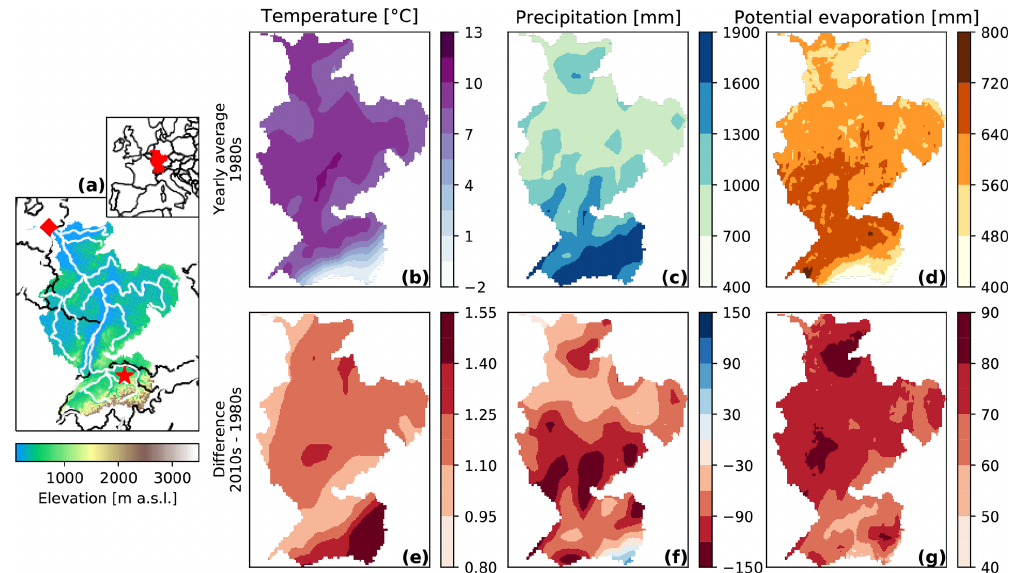
Figure 1. Digital elevation model of the Rhine, and hydro-meteorological changes between the 1980s and the 2010s. Panel (a) shows the simulation domain, with white lines indicating the main river branches. The red diamond indicates the location of the main outlet, and the red star indicates the location of the Rietholzbach research catchment using for validation. Inset shows the location of the basin within Europe. Panels (b) , (c) , and (d) show the yearly average values of the 1980s for temperature, precipitation, and potential evaporation, respectively, and panels (e) , (f) , and (g) show the differences between the 1980s and the